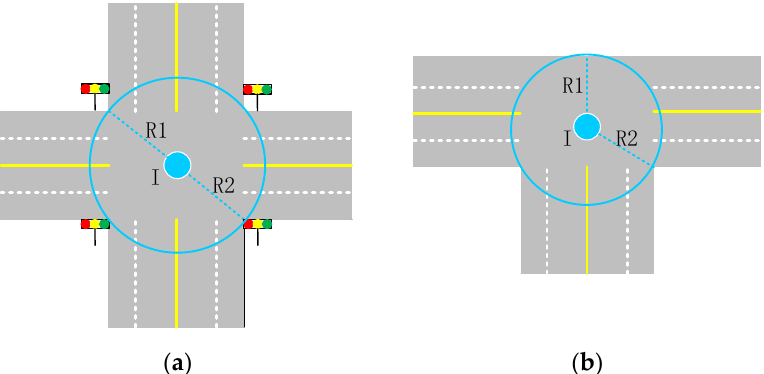
Figure 7. The radius of a road intersection: ( a ) X shape road intersections; ( b ) T shape road intersections. Algorithm 2: Radius computing algorithm by integrating Delaunay triangulation with circle shape structure